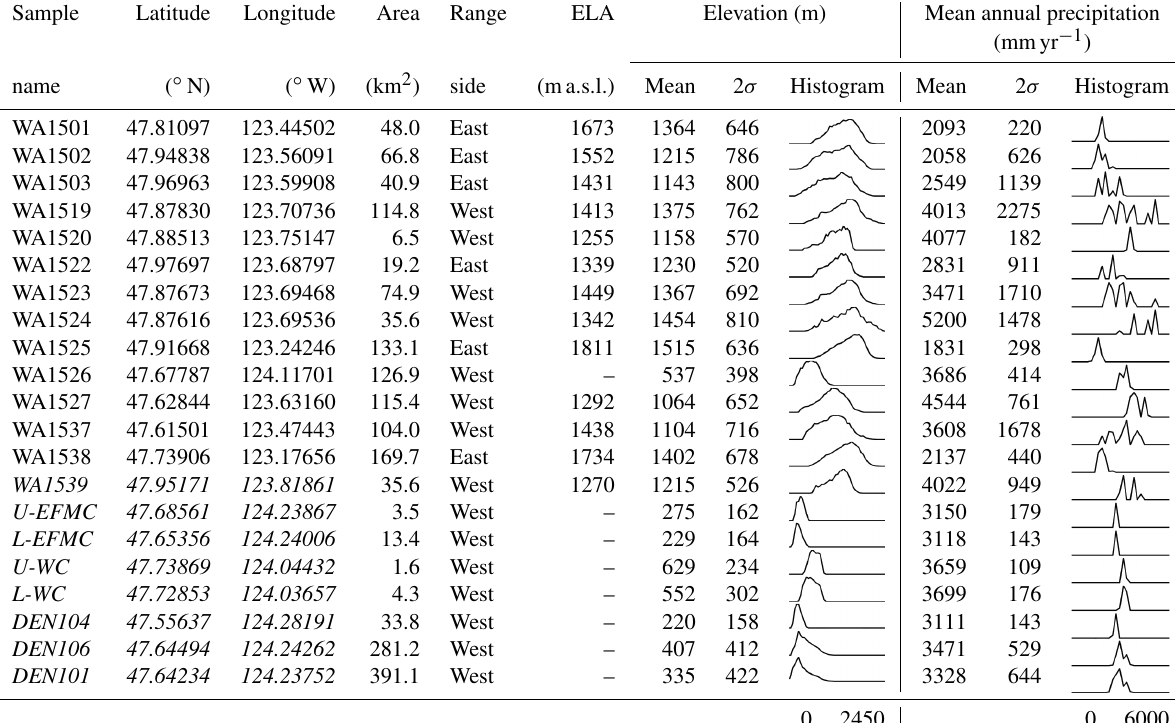
Table 1. Sample basin characteristics. Mean equilibrium line altitude (ELA) based on estimates from Porter (1964). 2 σ = 2 standard de- viations on the mean. Curves represent simplified histograms with normalized counts. See labels below each column for minimum and maximum bin values. Basins in italics are from Belmont et al.